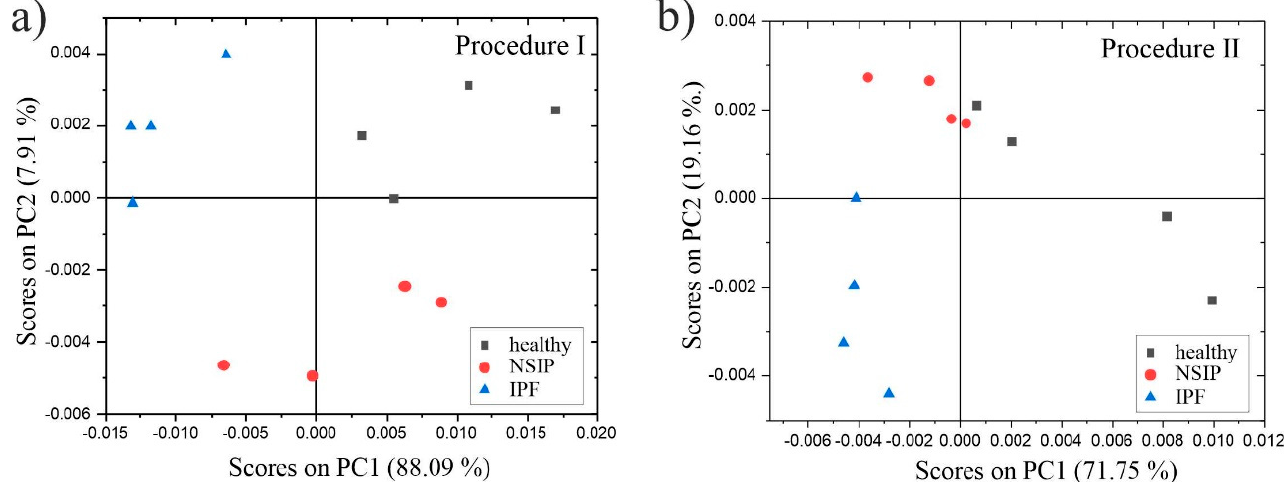
Figure 8. PCA score plots determined for healthy (black squares), NSIP (red circles), and IPF-derived (blue triangles) fibroblasts fixed to the surface following Procedure I ( a ), and Procedure II ( b ). Moreover, PC1, which captures the largest variance percentage, distinguished be- tween two reference cell lines, i.e., healthy (black squares) and IPF-derived (blue triangles)